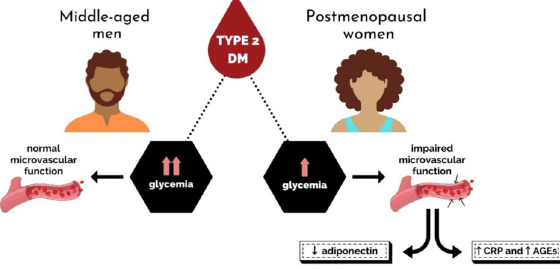
Figure 3. Graphical abstract showing that vascular dysfunction is associated with lower production of adiponectin and overproduc- tion of the pro-in fl ammatory mediators advanced glycation end products (AGEs) and C-reactive protein (CRP) in diabetic postmenopausal women, even though glycemia was lower than in